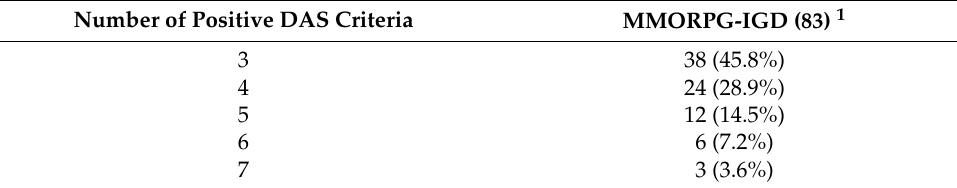
Table 2. Number of DAS criteria met in the MMORPG-IGD